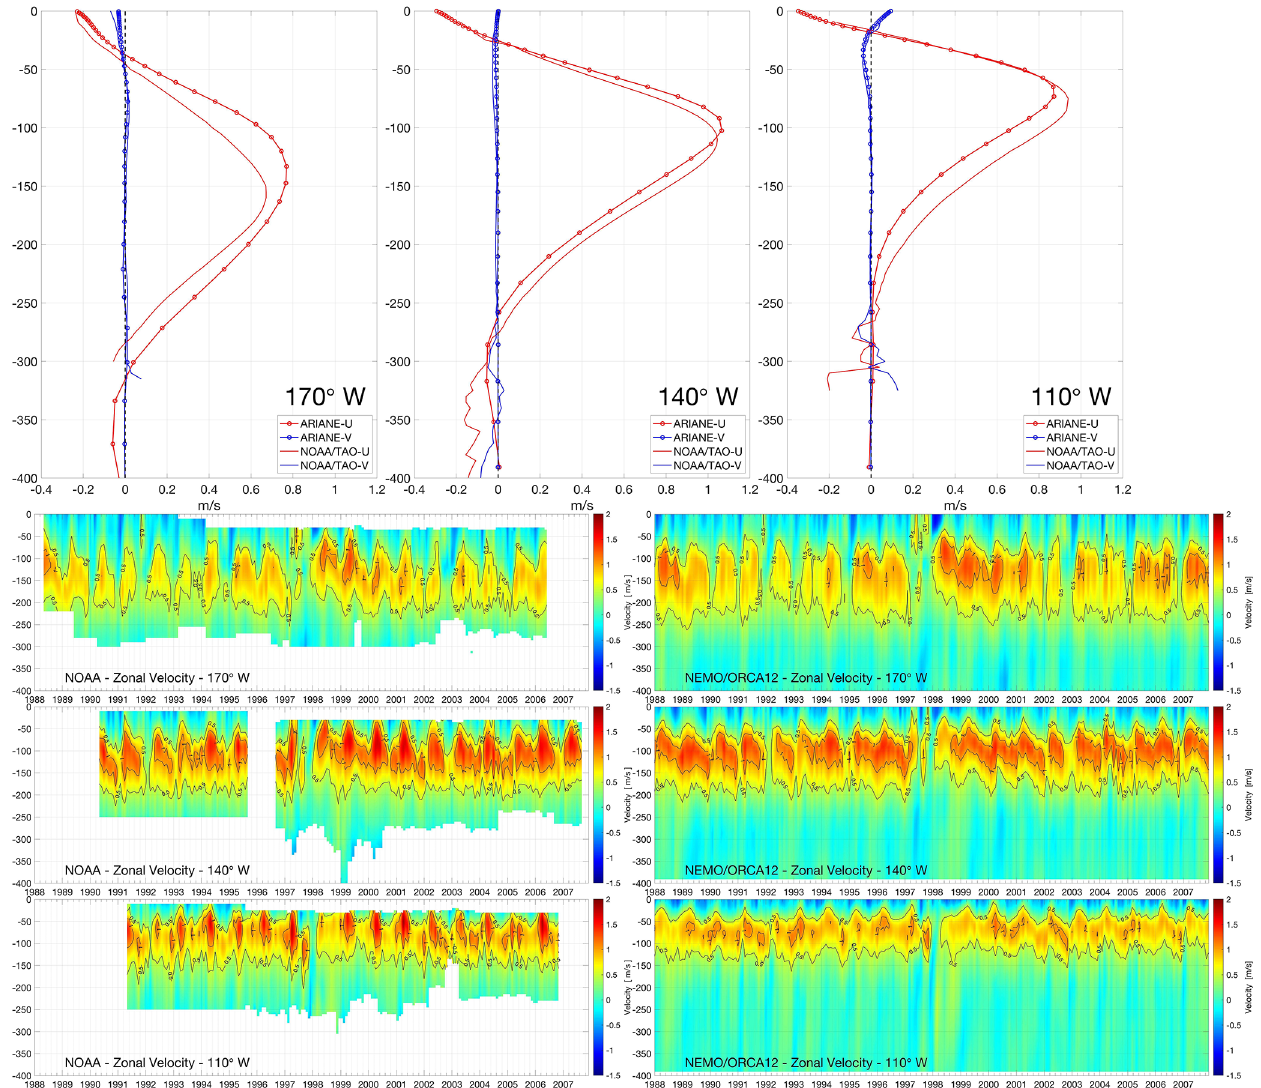
Figure 2. Vertical profiles for zonal and meridional velocity components (red and blue, respectively) averaged over 1988–2007 (first top panel), and monthly vertical sections for zonal velocity component (bottom panels, contour lines highlight 0.5 and 1.0ms − 1 ) in the NEMO- ORCA12 hindcast and NOAA mooring at 170, 140 and 110 ◦ W longitudes,